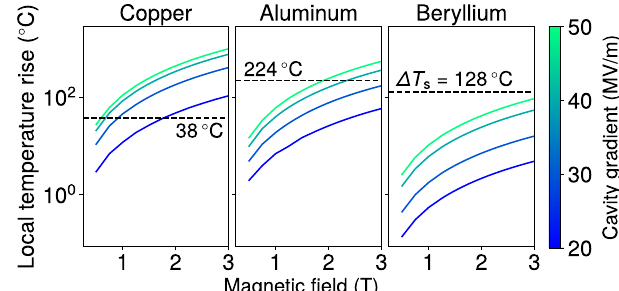
FIG. 2. Semi-log plot of local Δ T for Cu, Al, and Be cavities at various gradients and across a range of solenoidal magnetic field strengths. Δ T [Eq. (4)] is indicated in each plot by a horizontal, s dashed line. Note that for Be, the local temperature rise is lower than Δ T for a broad range of gradients and magnetic fields. s